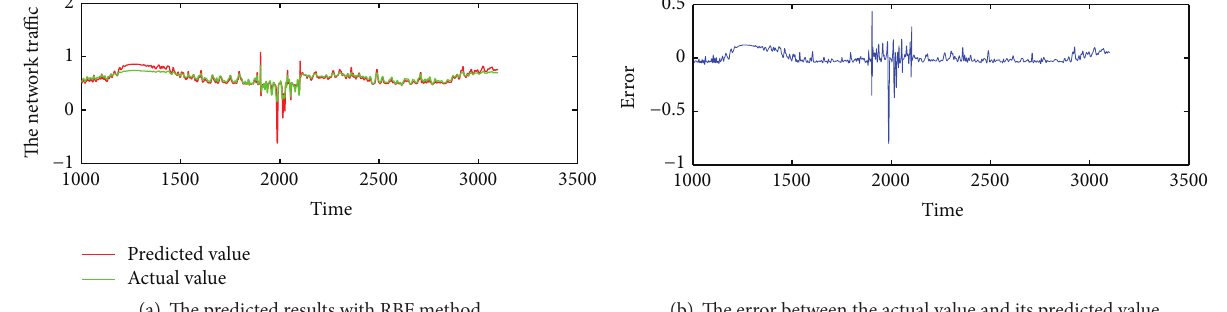
Figure 7: Prediction results with RBF neural network.